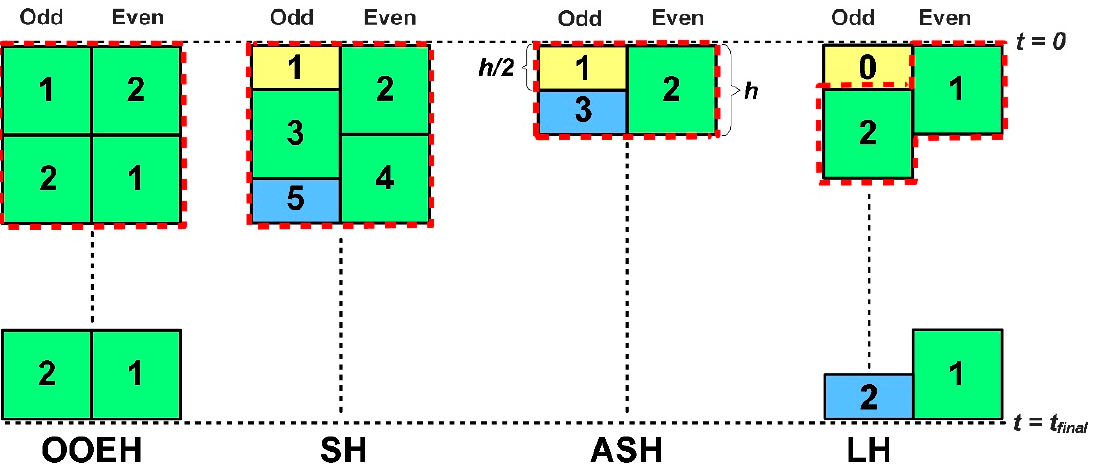
Figure 4. Hopscotch-type space-time structures. The time elapses from the top ( t = 0) to the bot- tom.